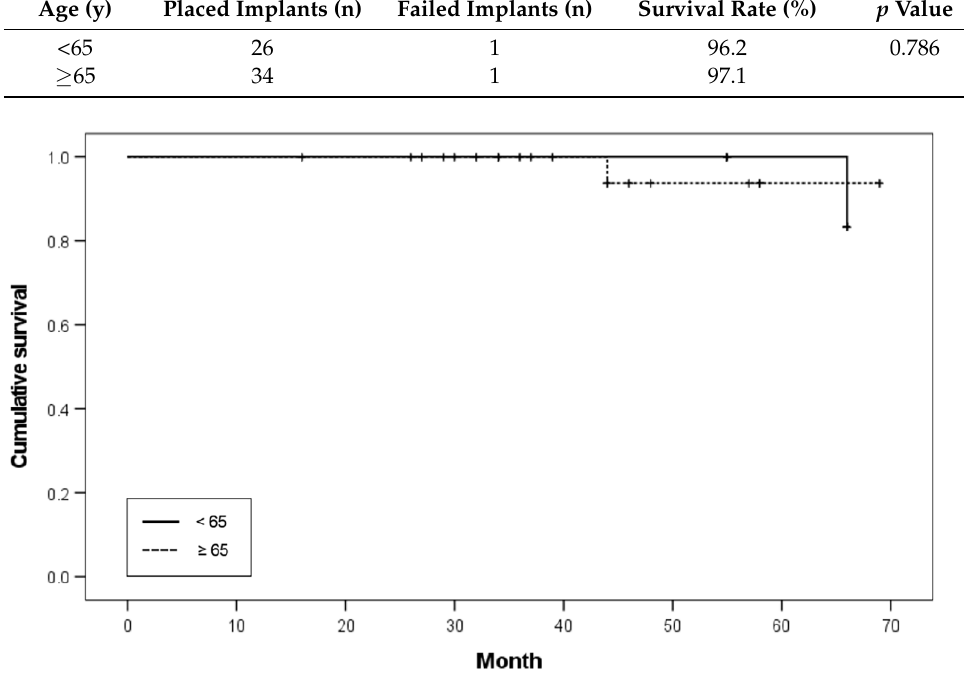
Table 3. Survival rate according to age.